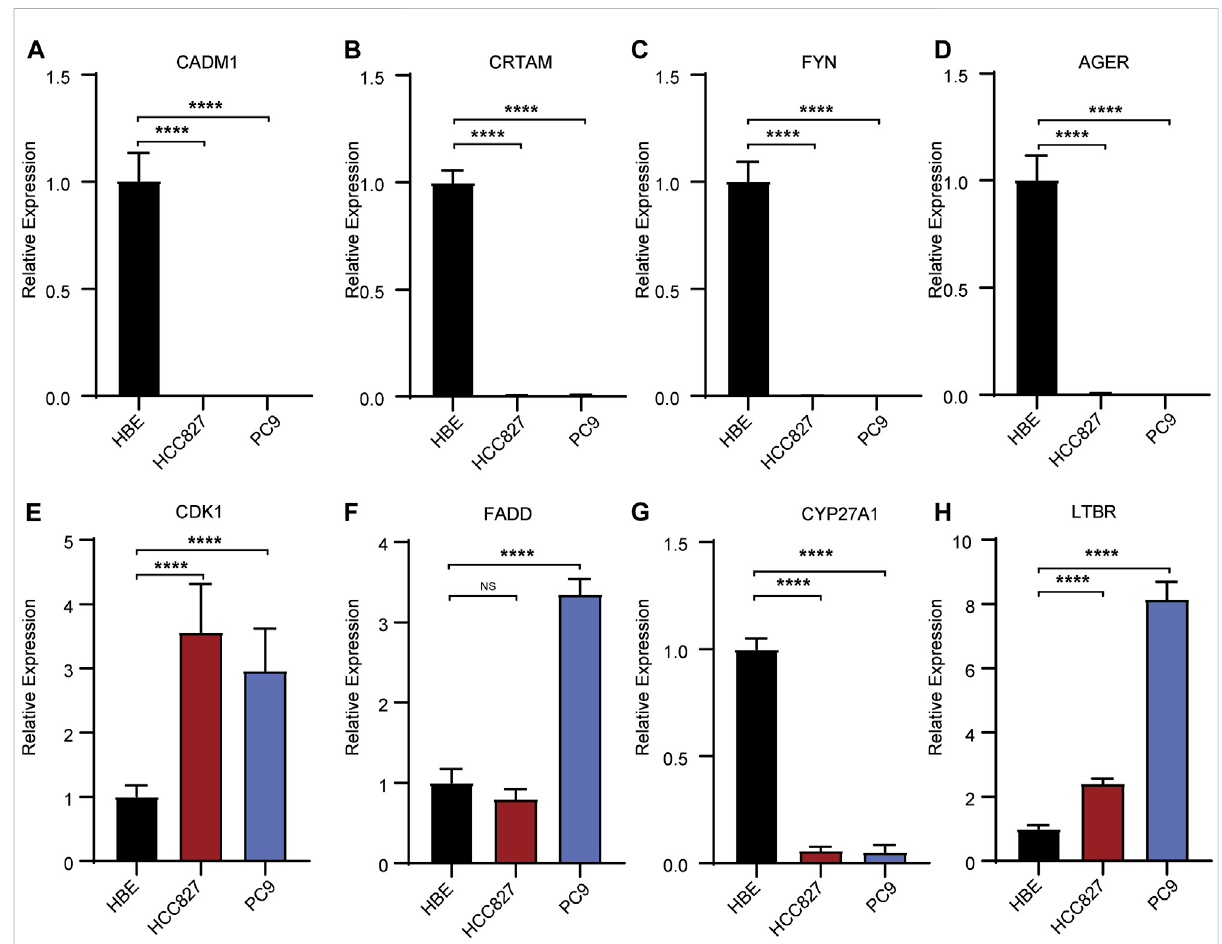
FIGURE 13 Validation of the expression of risk signatures in lung cancer cell lines (PC9 and HCC827) and normal lung cell (HBE) by RT-PCR analysis. (A – D,G) The expression of CADM1, CRTAM, FYN, AGER (A – D) and CYP27A1 (H) were decreased in normal lung cell lines. (E, F, H) The expression of CDK1, FADD (E, F) and LTBR (H) were unregulated in normal lung cell lines. * p < 0.05, ** p < 0.01, *** p < 0.001, **** p <